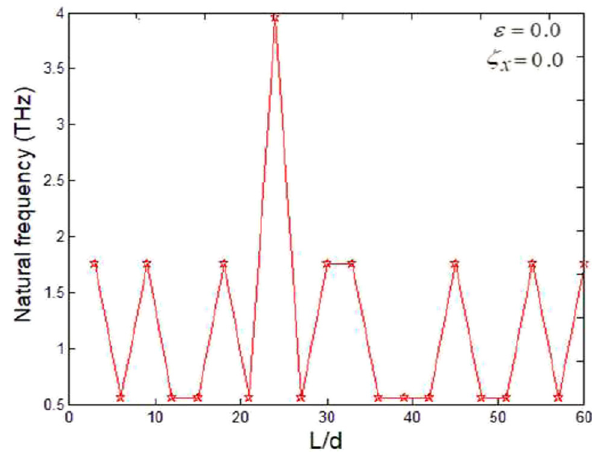
Figure 2: Variations in the natural frequency of uniform ( ε = 0.0 ) initial stress - free ( ζ = 0.0 ) single - walled carbon nanotube against aspect ratio ( L / d )